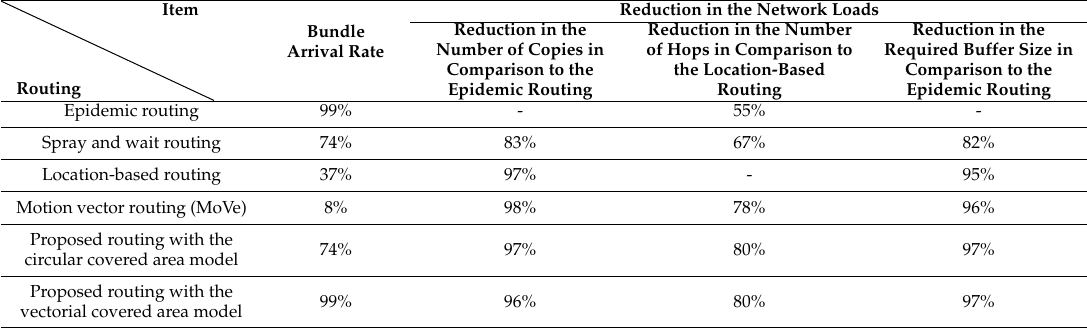
Table 5. Comprehensive evaluation.